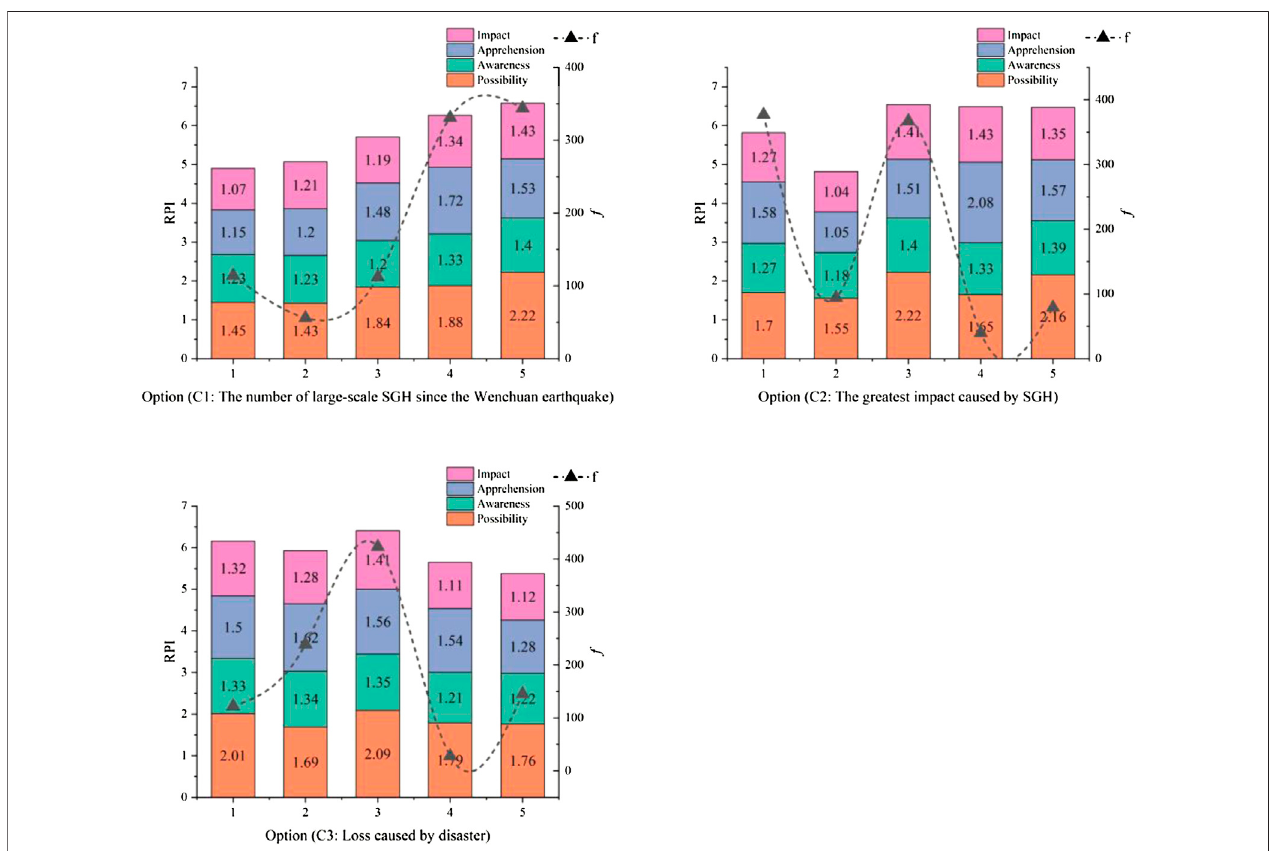
FIGURE 5 | The impact of disaster experience on risk